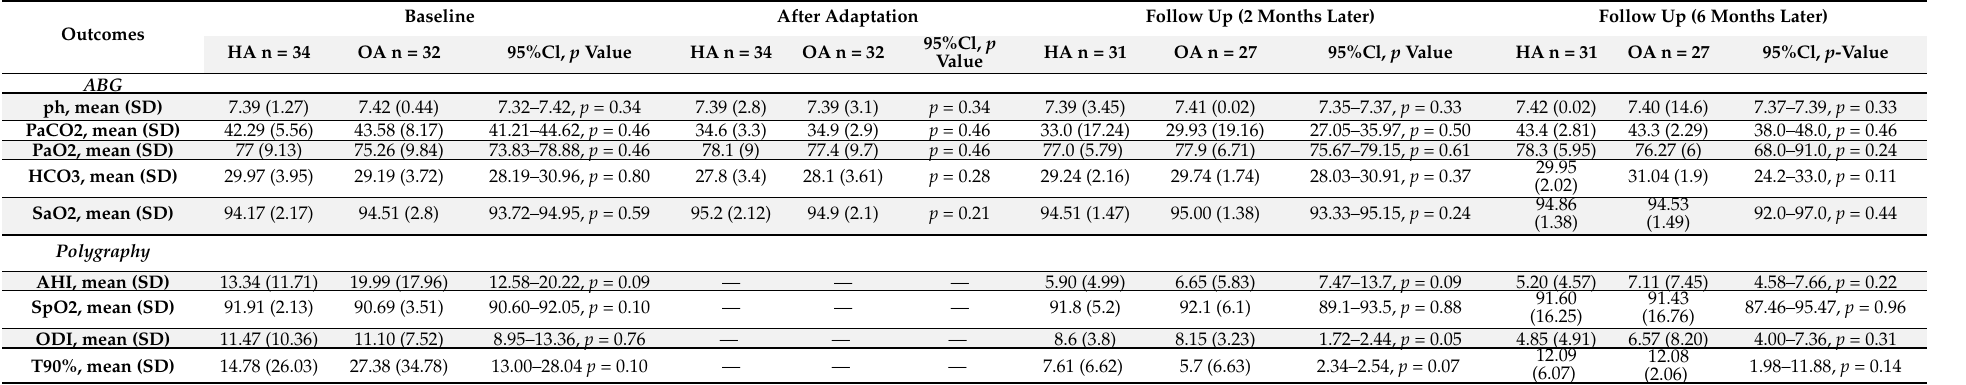
Table 2. Arterial blood gas analysis and polygraphy between